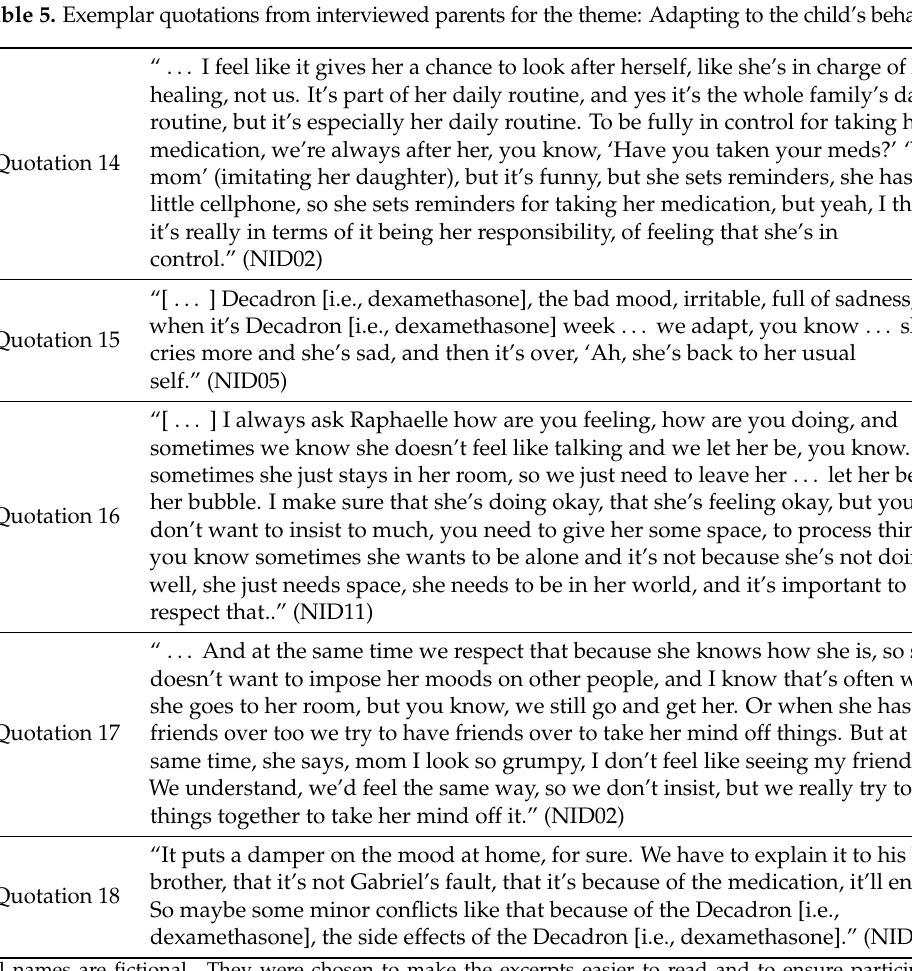
Table 5. Exemplar quotations from interviewed parents for the theme: Adapting to the child’s behavior.